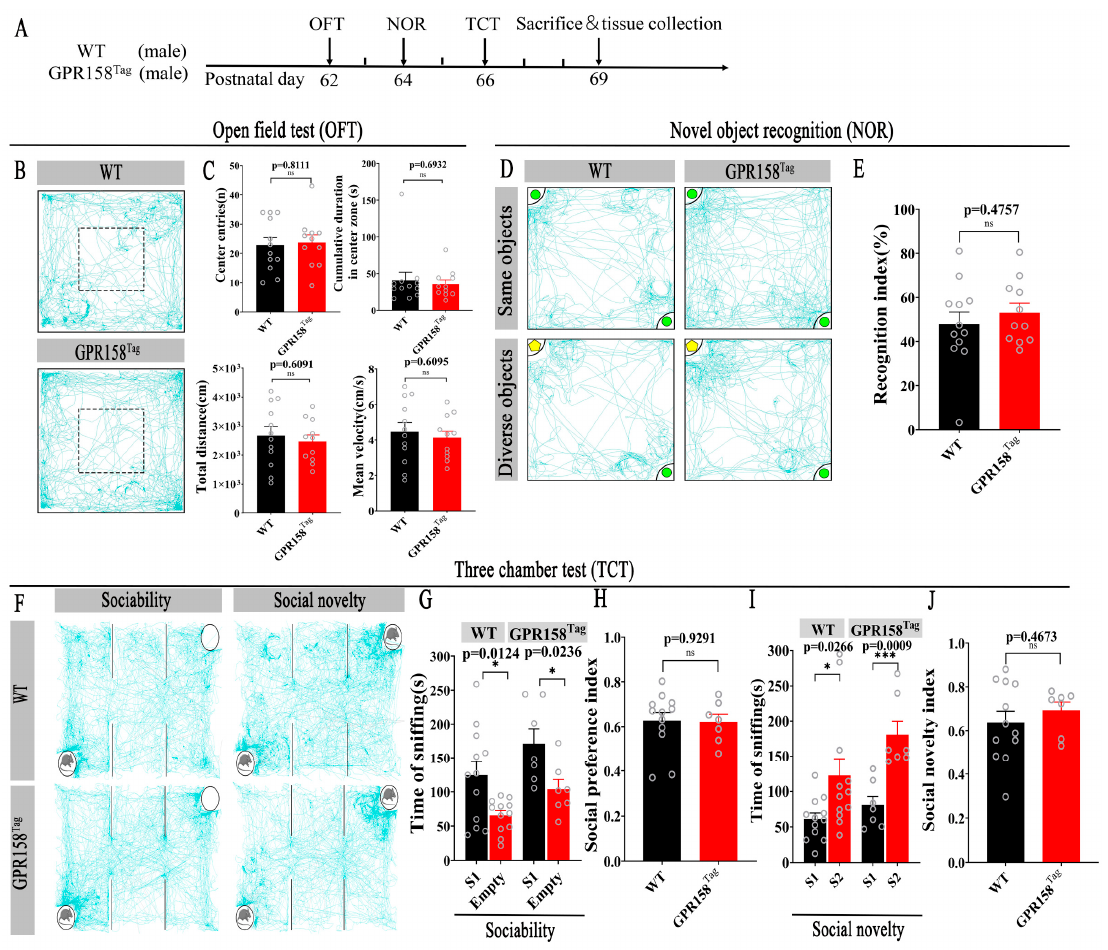
Figure 2. Behavioral tests of GPR158 Tag mice. ( A ) Timeline of behavioral tests of GPR158 Tag mice. ( B ) Representative trajectory diagrams interpreting time spent in different areas of the open field box for WT and GPR158 Tag mice. ( C ) Bar graphs showing absence of motor deficits and anxiety-like be- havior in GPR158 Tag mice compared to control mice, as shown in the open field test ( n = 12, WT, male; n = 11, GPR158 Tag , male, P60-P90; ns, not significant; two-tailed Student’s t test). ( D ) Repre- sentative trajectory diagrams illustrating exploration time of WT and GPR158 Tag mice for familiar and novel objects during novel object recognition test. ( E ) Bar graphs showing no cognitive deficits in GPR158 Tag mice compared to control mice during the novel object recognition experiment ( n = 12, WT, male; n = 11, GPR158 Tag , male, P60-P90; p = 0.4757, two-tailed Student’s t test). ( F ) Representative trajectory diagrams interpreting the duration of socialization of WT and GPR158 Tag mice with Stranger Mouse 1 and the duration of novelty of socialization with Stranger Mouse 2 in the three- chamber test. ( G , H ) GPR158 Tag mice showed normal sociability compared to WT mice in the three- chamber socialization experiment ( G ). Social preference index was calculated so that it could be judged that there was no difference in the sociability of GPR158 Tag mice compared to WT mice ( H ; n = 12, WT, male; n = 7, GPR158 Tag , male, P60-P90; two-tailed Student’s t test, * represents p -value less than 0.05; ns, not significant). ( I , J ) Three-chamber sociability test demonstrating no social nov- elty deficits in GPR158 Tag mice compared to WT mice ( I ). Social novelty index was calculated so that it could be judged that there was no difference in the social novelty ability of GPR158 Tag mice com- pared to WT mice ( J ); n = 12, WT, male; n = 7, GPR158 Tag , male, P60-P90; two-tailed Student’s t test, * represents p-value less than 0.05; *** represents p -value less than 0.001; ns, not significant). Data are mean ± SEM.